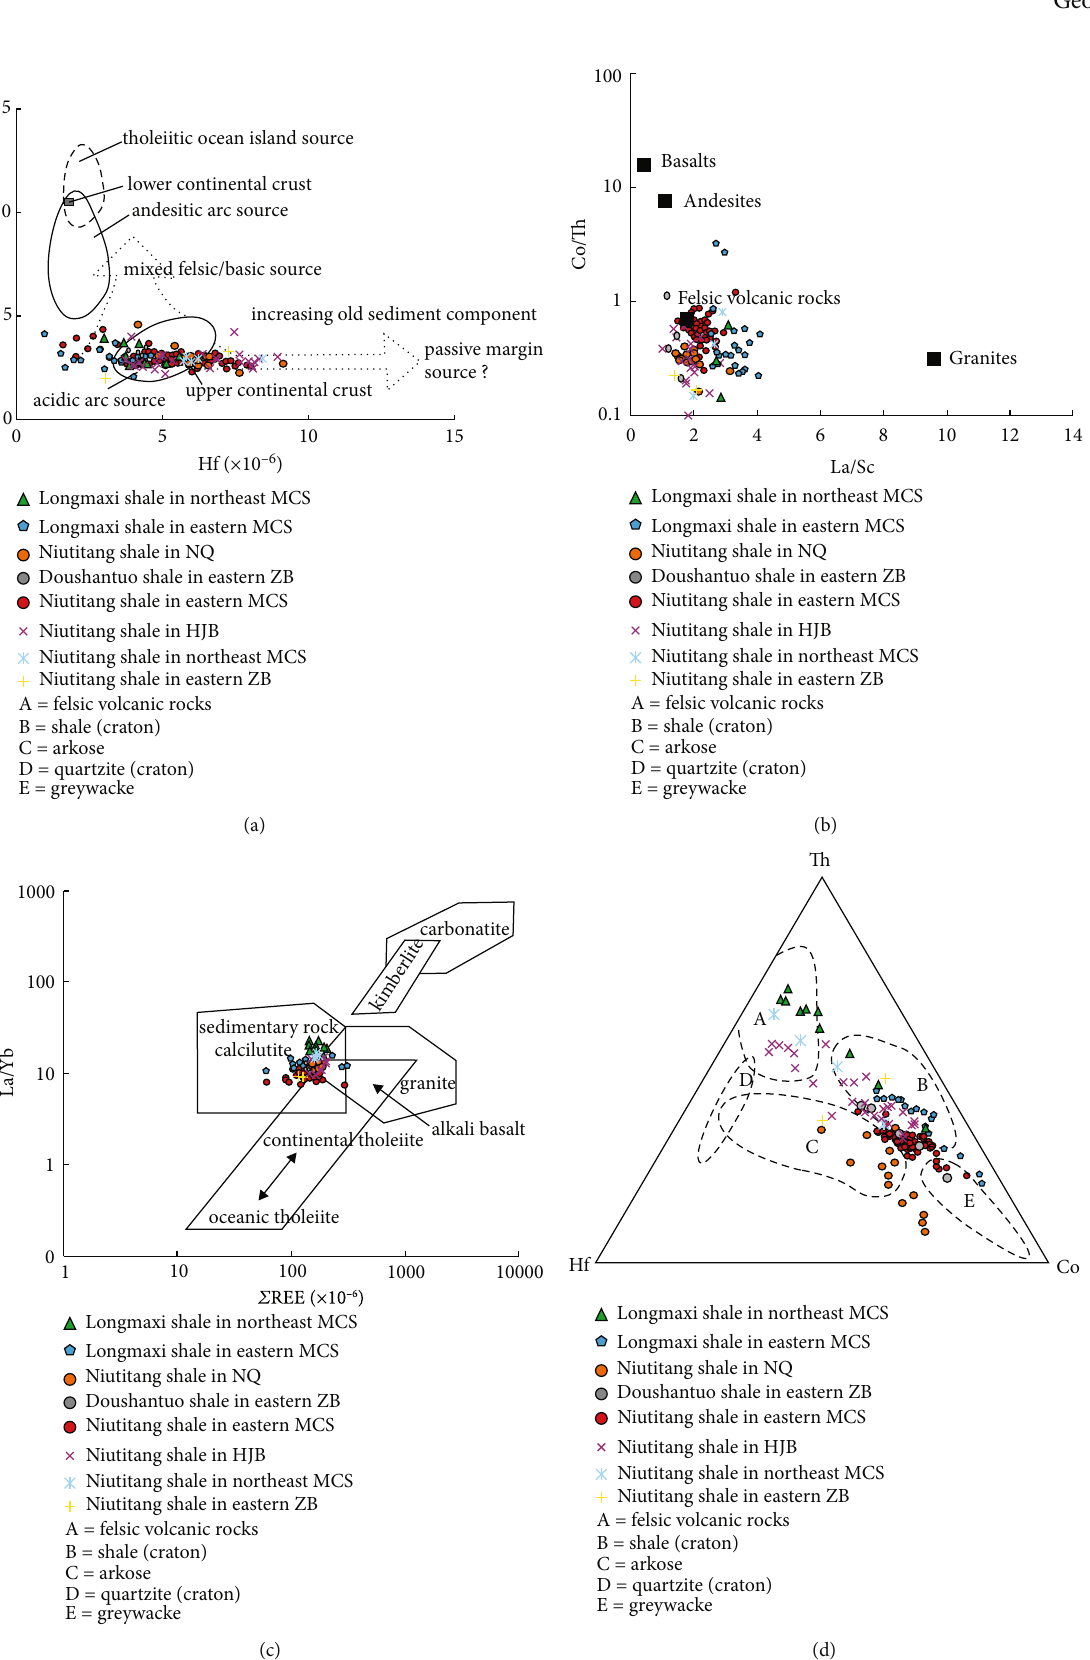
Figure 2: Discrimination diagrams illustrating sedimentary provenance of shale in Micangshan tectonic belt. (a) La/Th against Hf diagram (after [32]); (b) Co/Th against La/Sc diagram (after [34]); (c) La/Yb against REE diagram (after [36]); (d) Th-Hf-Co diagram (after